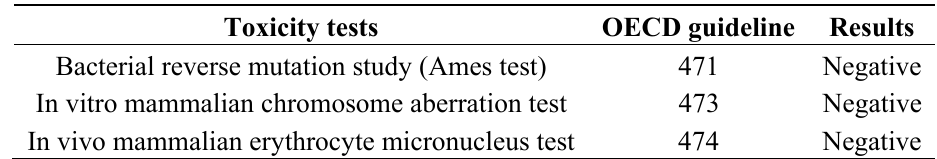
Table 3. Mutagenicity studies of